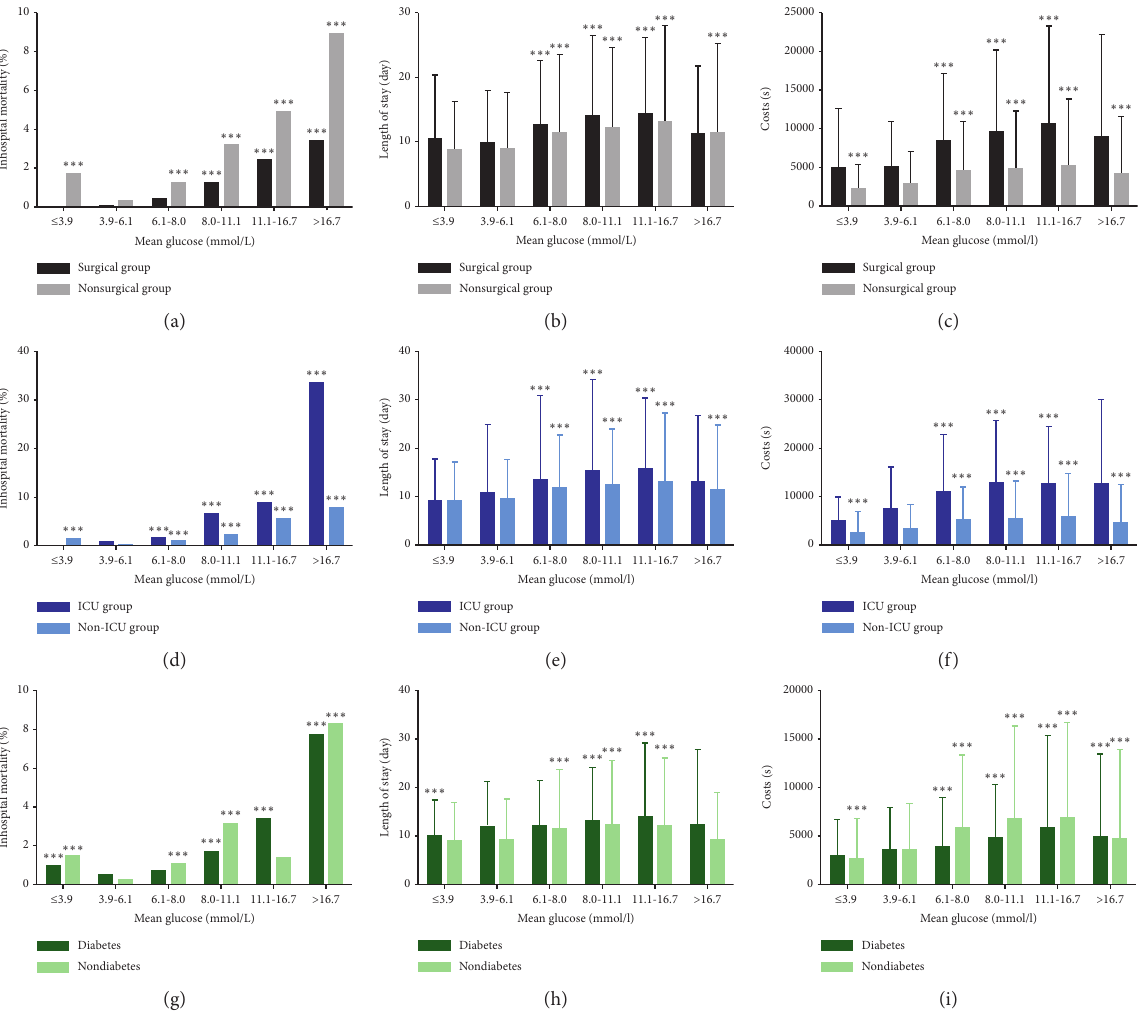
Figure 1: Subgroup analyses of the associations between mean plasma glucose and clinical outcome. (a–c) Correlation of inhospital death proportion (a), hospitalization days (b), and medical costs (c) with mean plasma glucose in further surgical/nonsurgical subgroup analyses. (d–f) Correlation of inhospital death proportion (d), hospitalization days (e), and medical costs (f) with mean plasma glucose in further ICU/non-ICU subgroup analyses. (g–i) Correlation of inhospital death proportion (g), hospitalization days (h), and medical costs (i) with mean plasma glucose in further diabetes/nondiabetes subgroup analyses. ∗∗∗ : P < 0 . 001, compared with normoglycemia (3.9–6.1mmol/L) group. ICU, intensive care